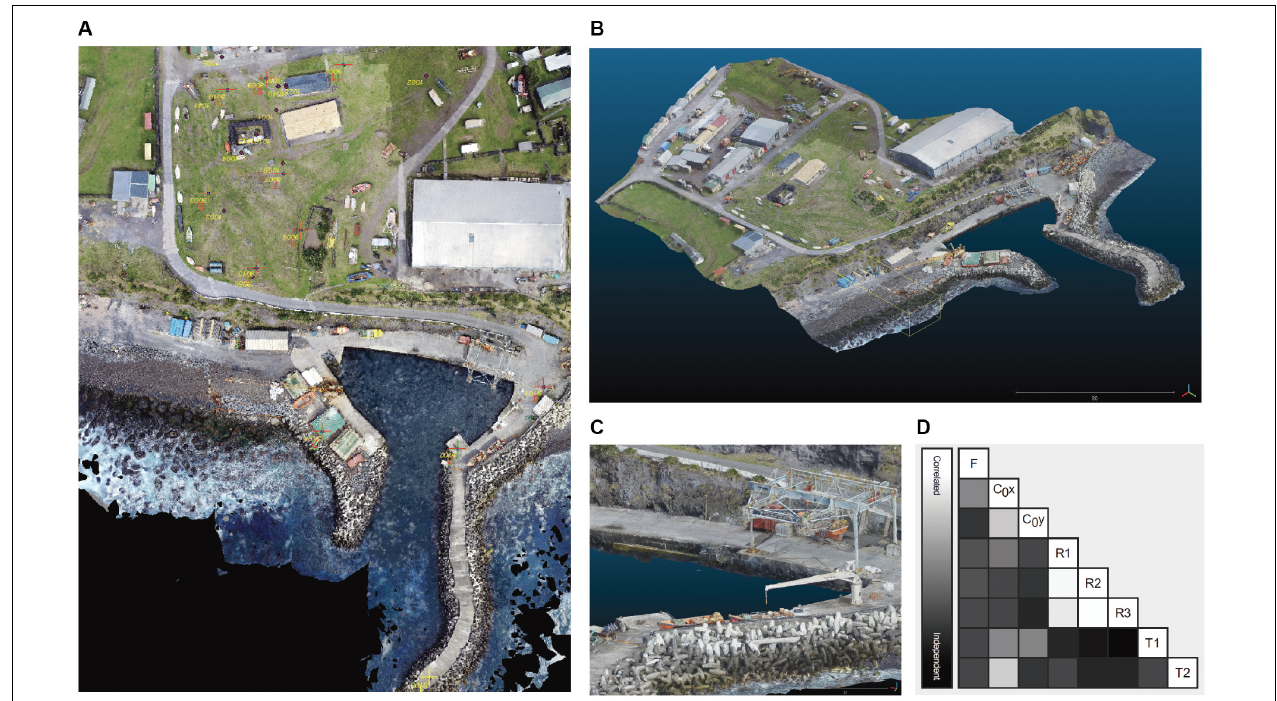
FIGURE 10 | (A) Orthophoto generated from drone images with GCPs. (B) Overview dense point cloud from drone survey. (C) Perspective view of harbor area. (D) Cross-correlation matrix for camera calibration